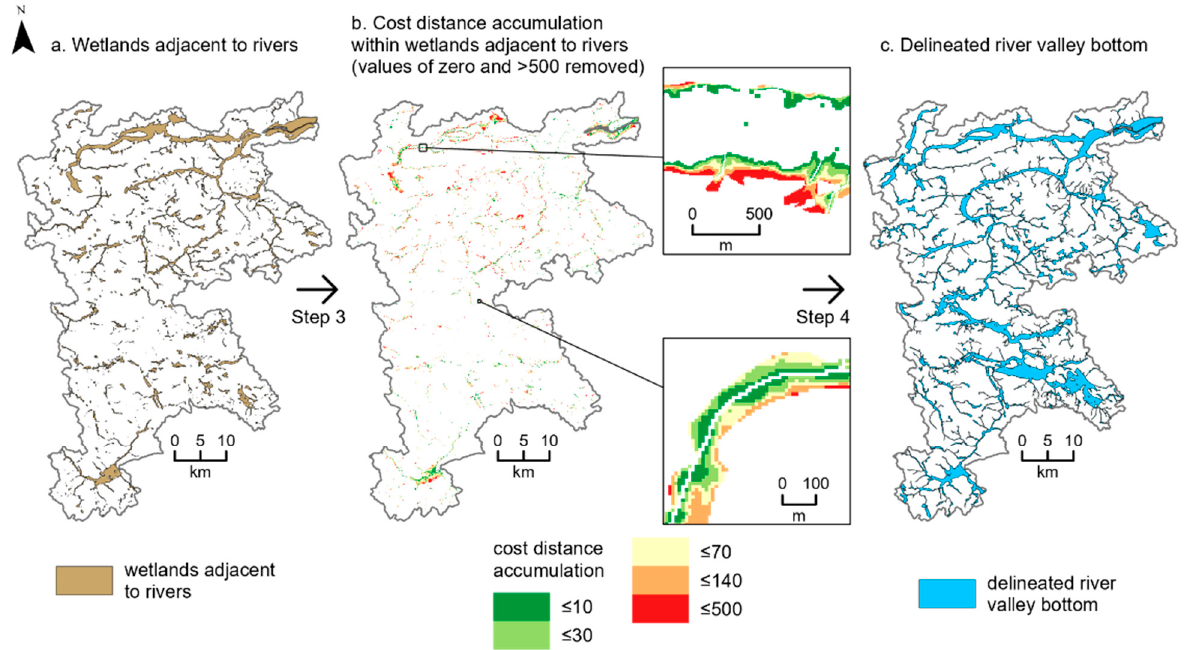
Figure 8. Subsequent steps that our approach takes to delineate the river valley bottom. At Step 3, using ( a ) wetland areas adjacent to rivers as input, we extract ( b ) the cost distance accumulation values falling within and filter them to remove outliers (extracting only values between zero and 500). At Step 4, we use ( b ) to calculate the mean of the values, which we use as a basis to delineate ( c ) the river valley bottom from the cost distance accumulation of the drainage basin.